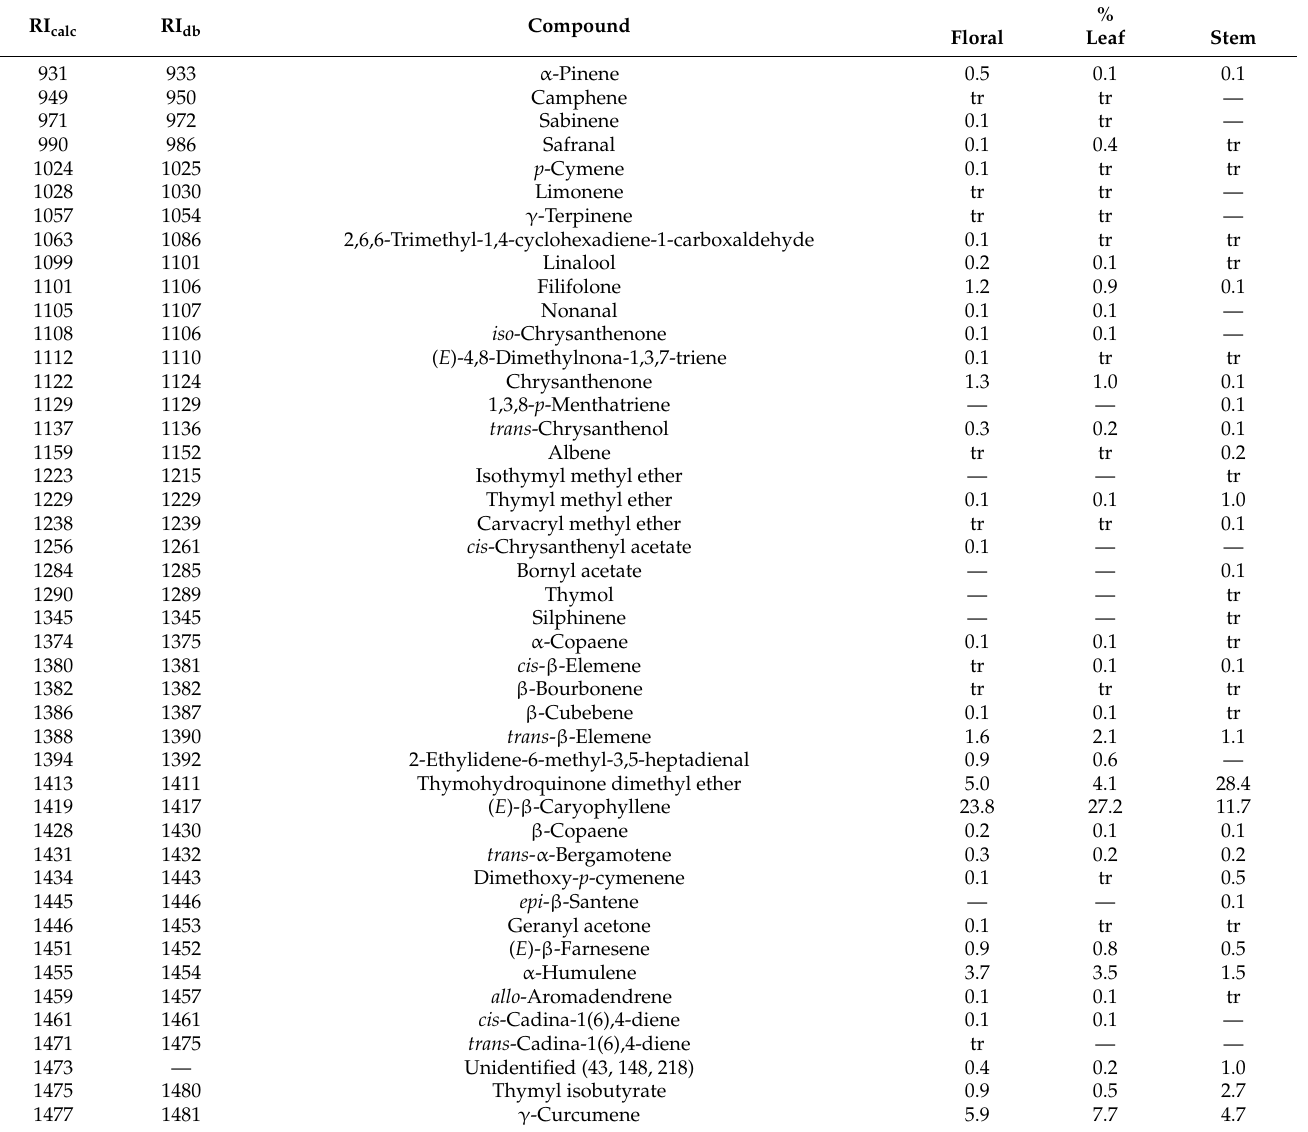
Table 1. Chemical compositions of Blumea lacera essential